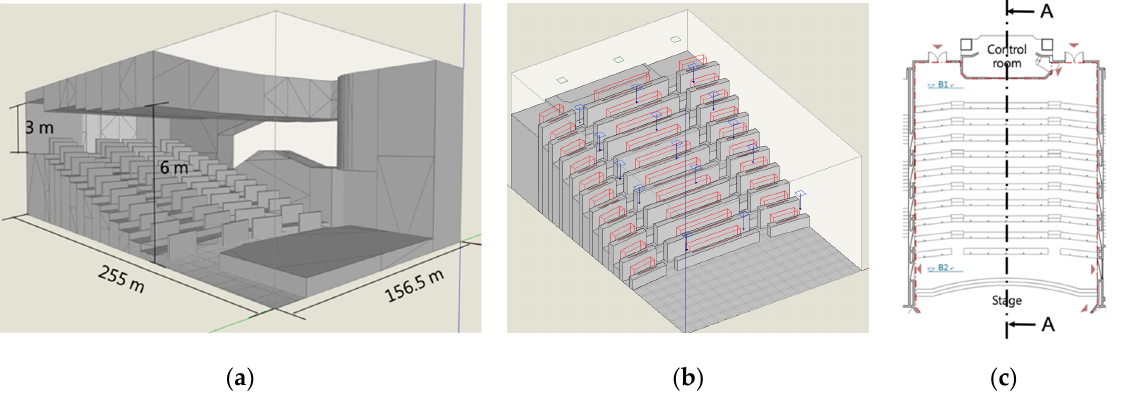
Figure 3. Simulation model of the case building: ( a ) Size of simulation model; ( b ) Occupant area of model; ( c ) Cross section location of model.